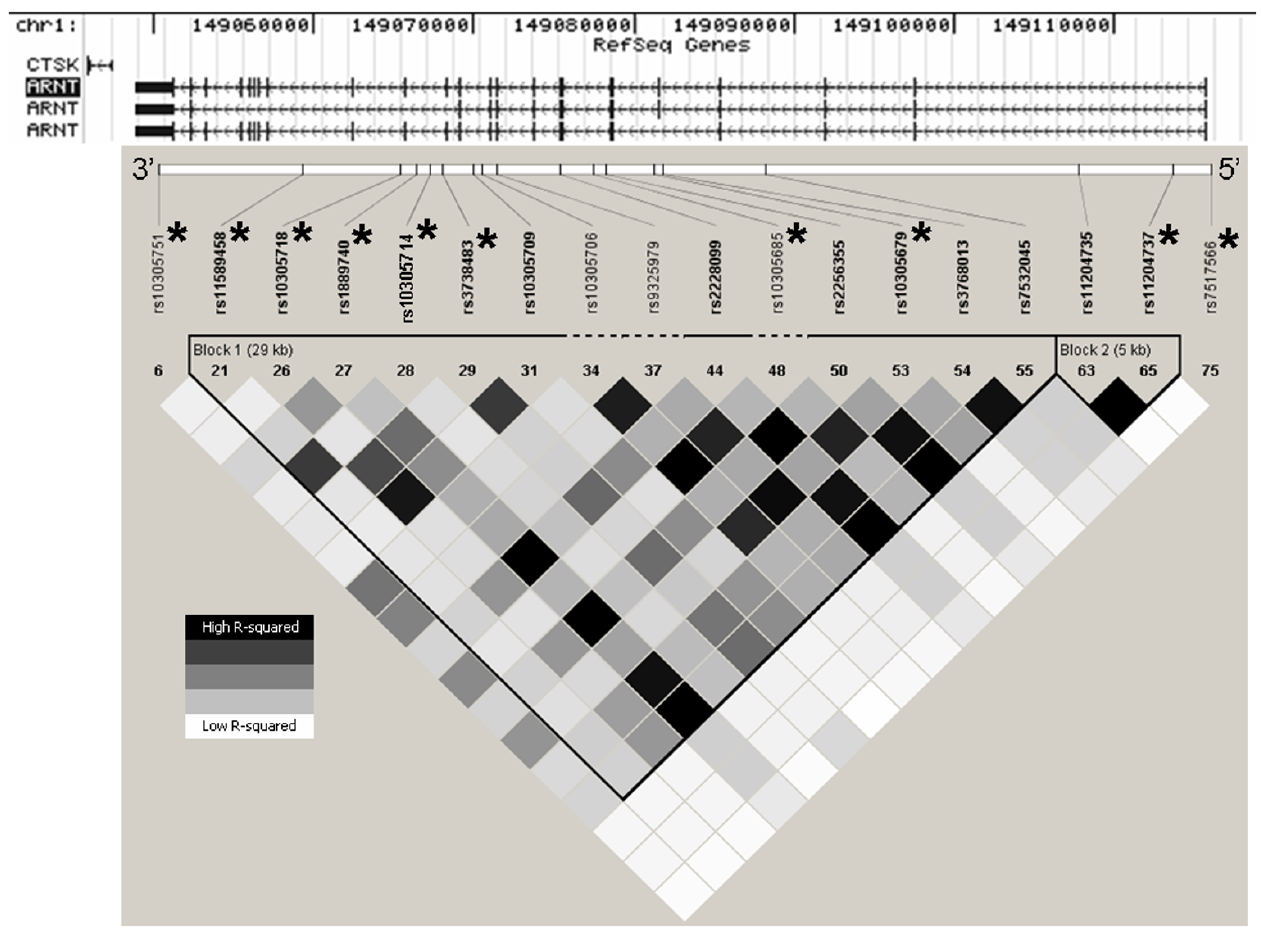
Figure 2, except shown in Yorubans for selection of SNPs in African Americans. Asterisks (*) identify markers selected for gen-